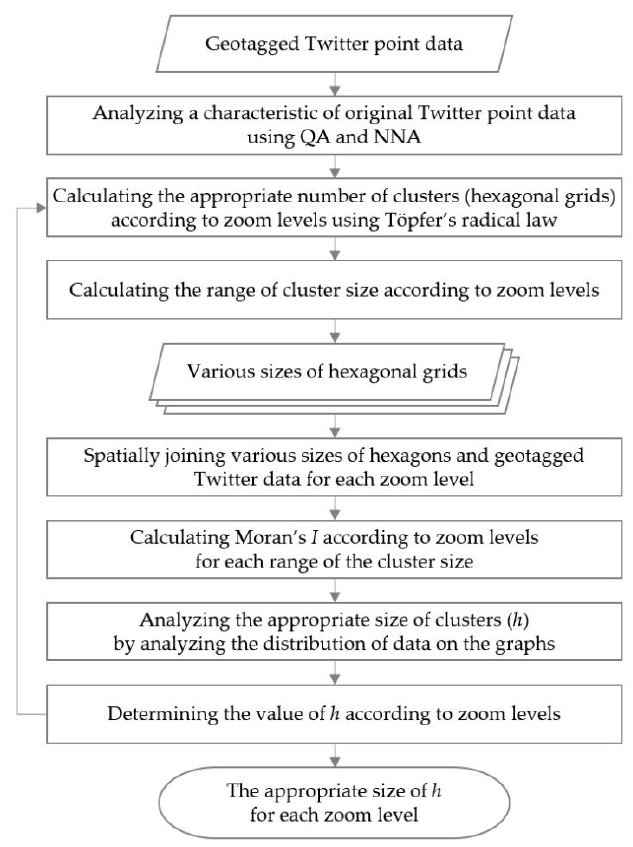
Figure 2. Flowchart of the process of determining the appropriate sizes of clusters.